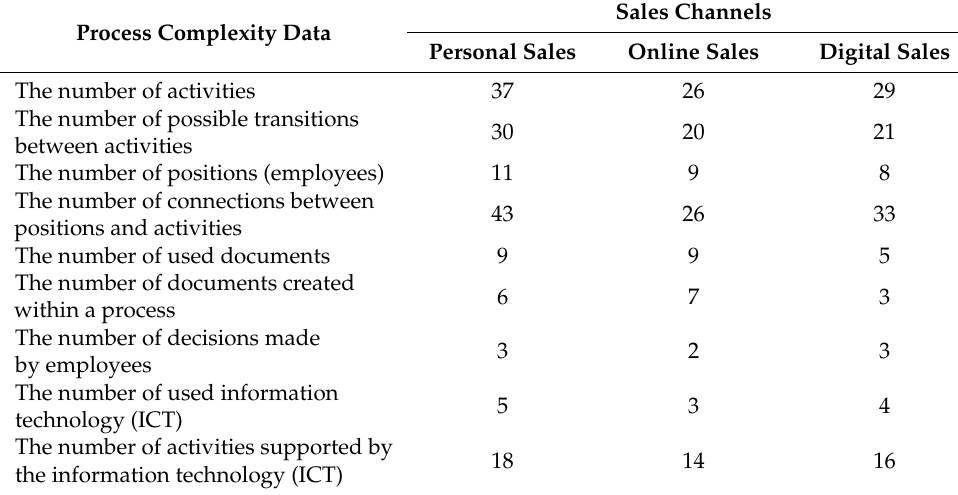
Table 5. Data of the process’s